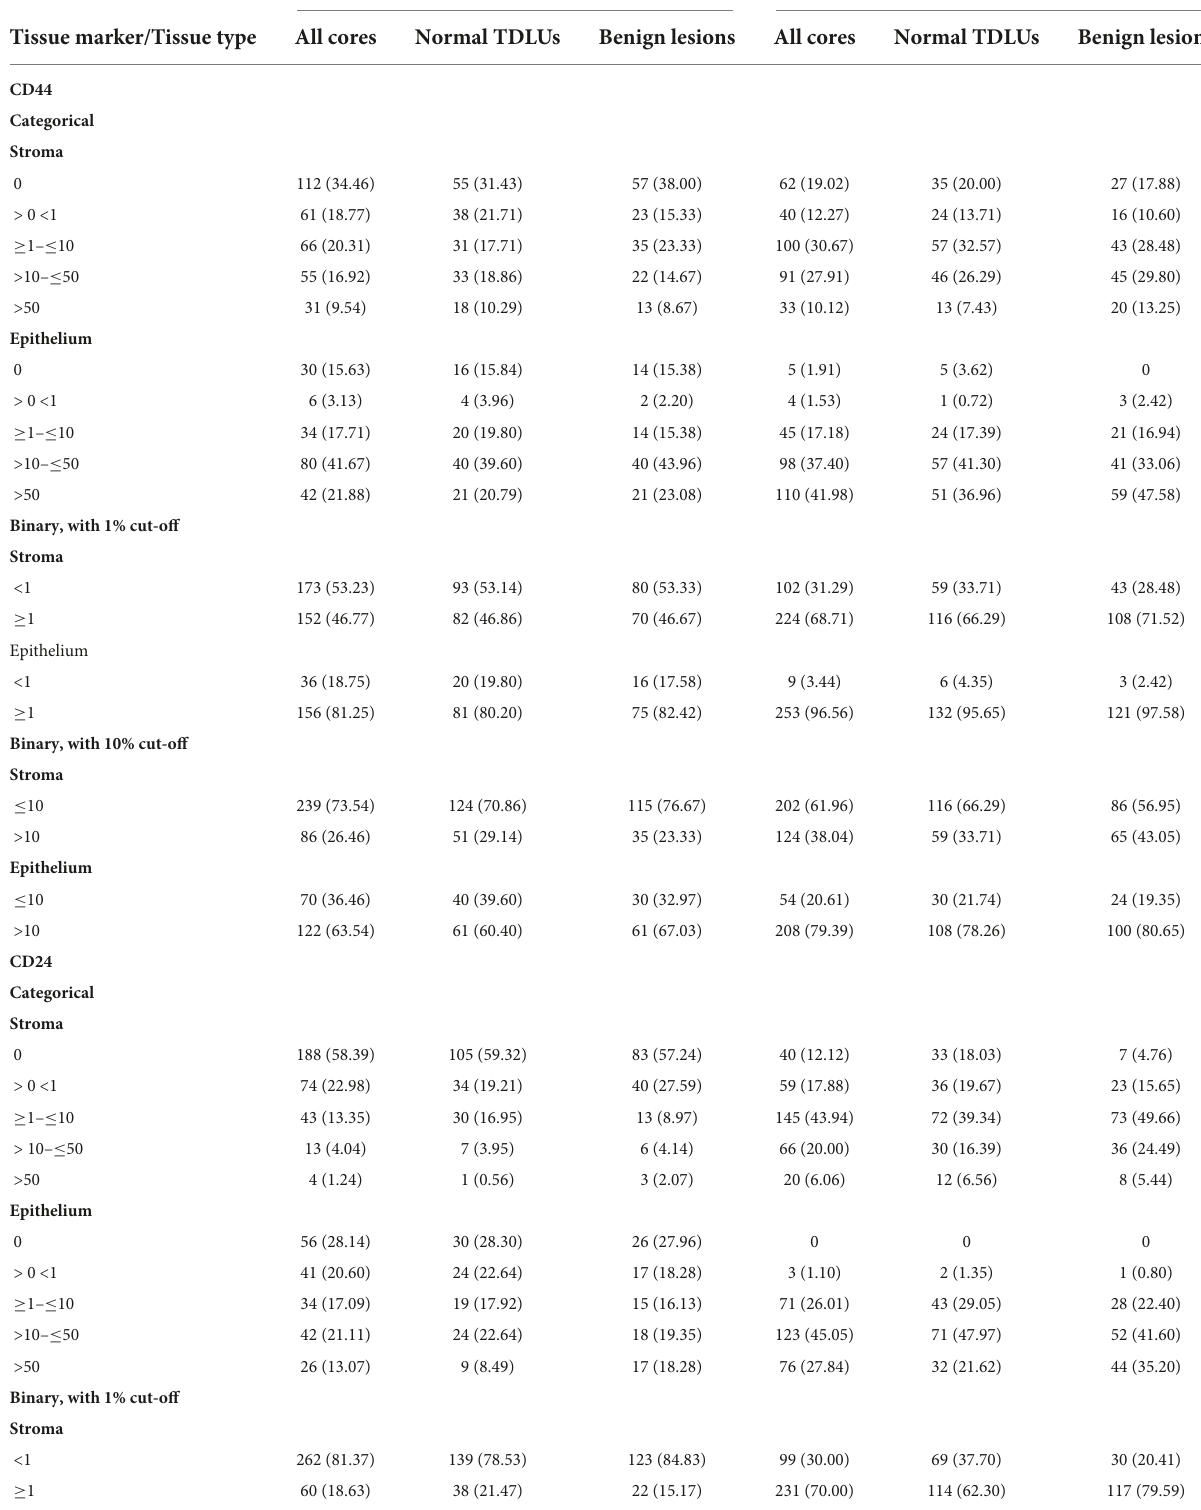
TABLE 2 Distribution of CD44, CD24, and ALDH1A1 expression assessments from pathologist and Definiens readings [ N of cores